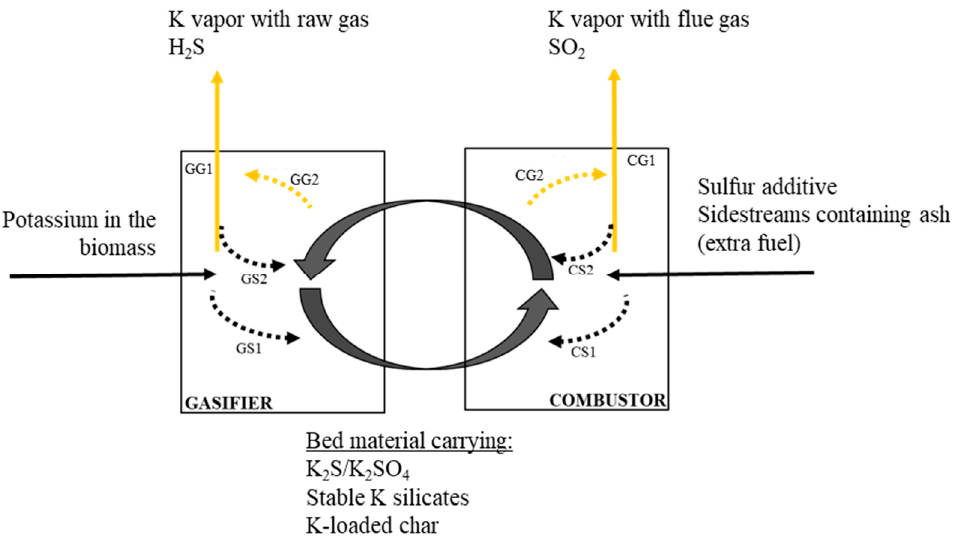
Figure 1. Transfer of alkali and sulfur-containing species between the reactors in a DFB system. G1, release of gaseous alkali from the fuel; G2, release of gaseous alkali from the bed material; S2, condensation of alkali vapors on bed material particles; S1, formation of solid alkali compounds; C, combustor; G, gasifier.